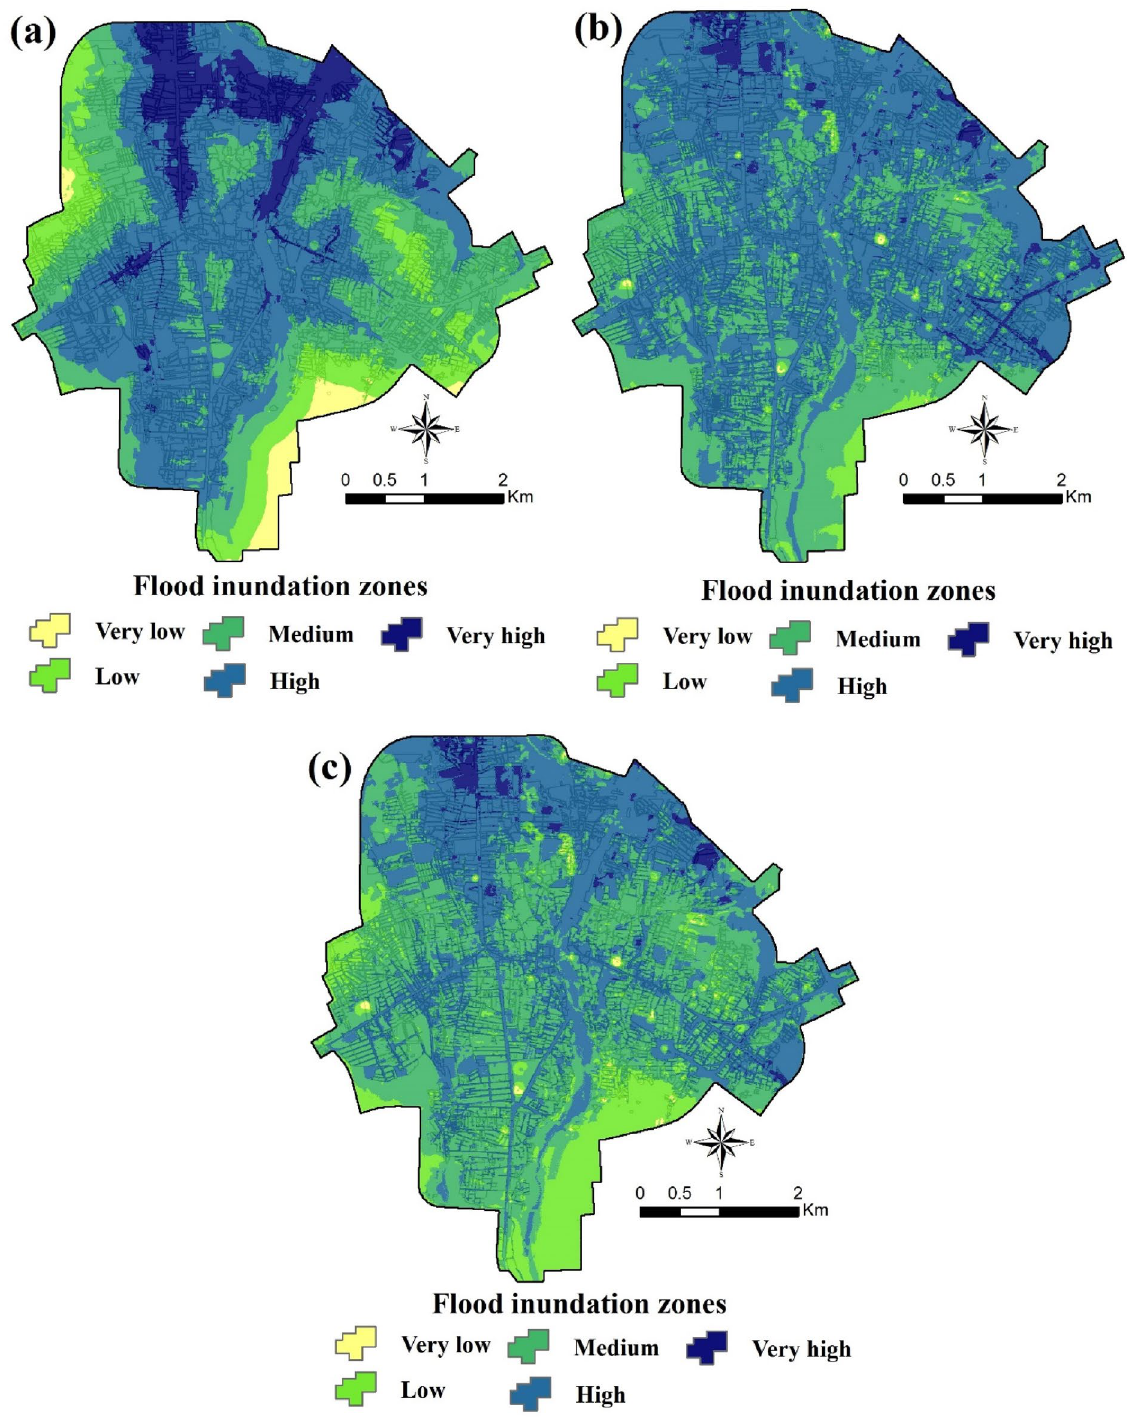
Figure 8. Flood inundation zone maps for the city of Amol produced by: ( a ) the SVR model, ( b ) the Wavelet- SVR-Bat model, and ( c ) the Wavelet-SVR-GWO model. These maps were generated using ArcGIS Desktop 10.7.1, https ://deskt op.arcgi